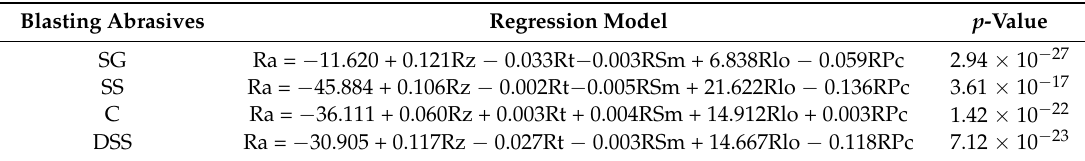
Table 8. Regressions models, p -value (Ra).